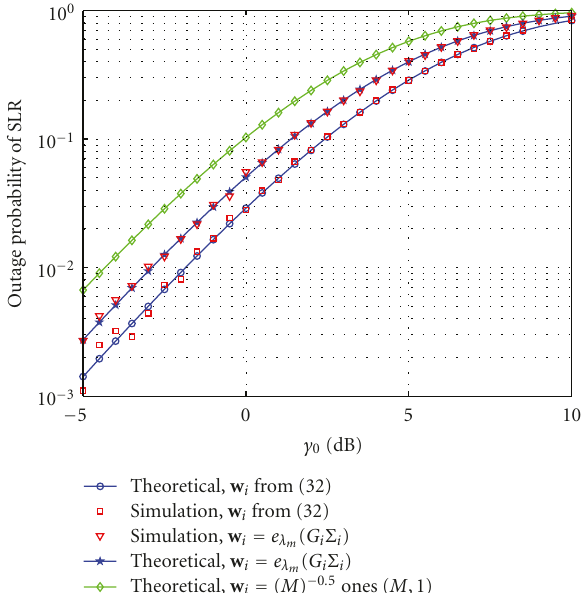
Figure 3: Comparison of outage probablity with di ff erent weight vectors as a function of γ 0 for user i = 1 (exponential correlation model).